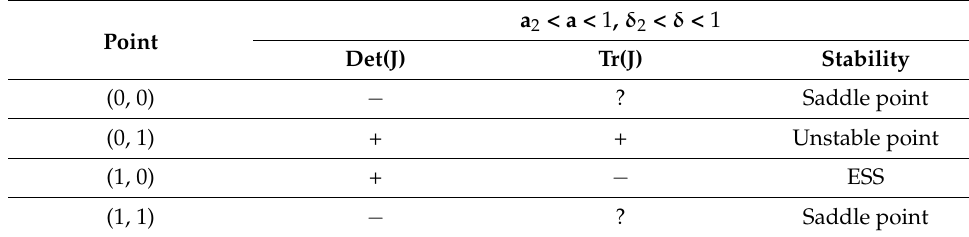
Table 9. Stability analysis of the points in case (3).